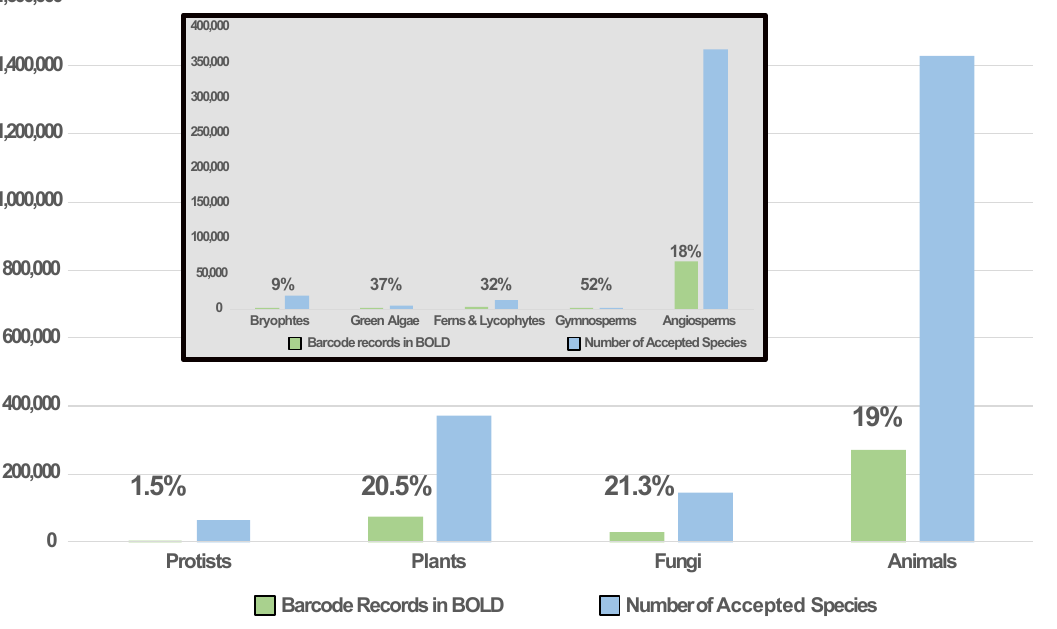
Figure 1. Numbers of species and DNA barcodes across the Tree of Life. The number of species in each of the four major groups of organisms on Earth (blue bars) according to the Catalog of Life are given along with the number of published barcode sequences in BOLD (green bars). Inset shows the major green plant clades (blue bars) with the number of barcode sequences in BOLD (green bars) adjacent to the number of accepted species (according to [11]). The estimated percentage of all species with DNA barcode sequences for that group is provided above the bars in this plot.